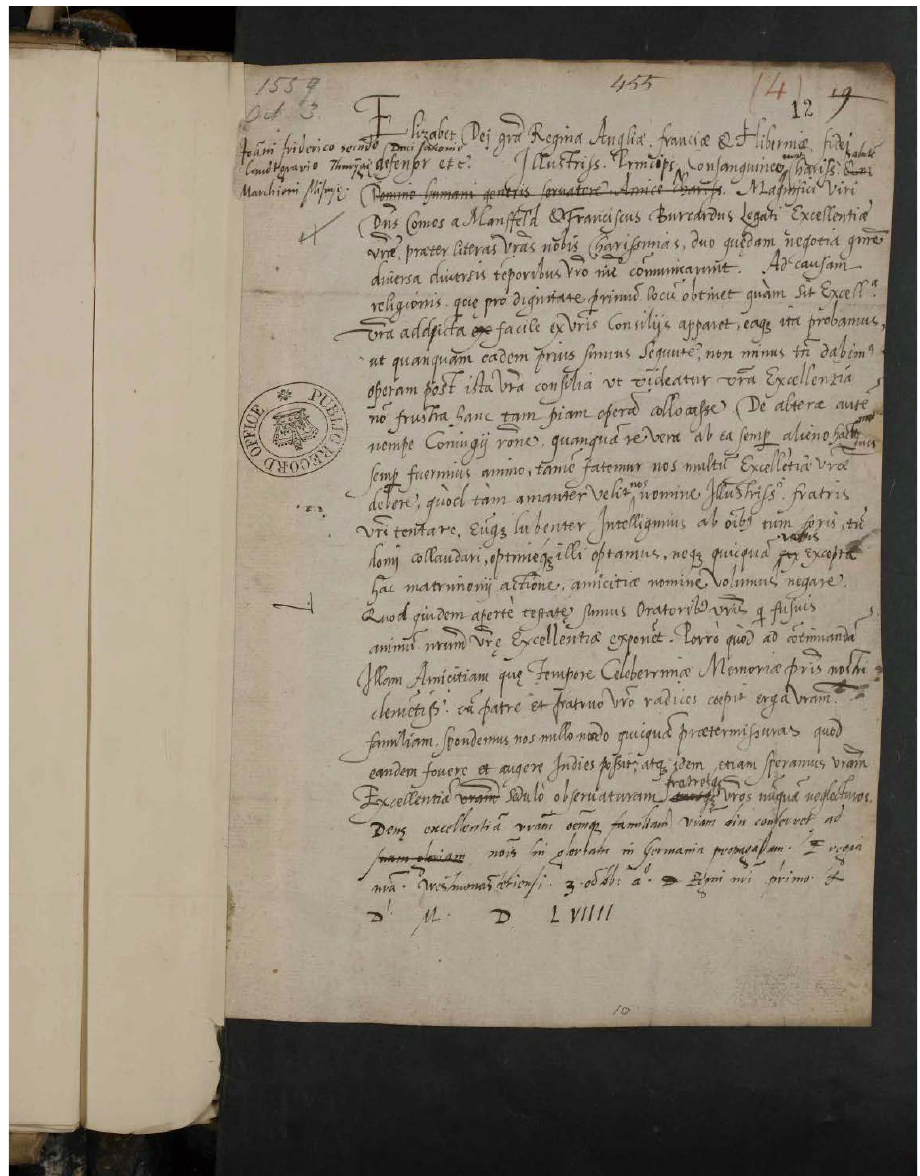
Fig. 3 – Draft of a letter to John Frederic II, Duke of Saxony, showing Cecil’s holograph additions (reproduced by permission of the National Archives,